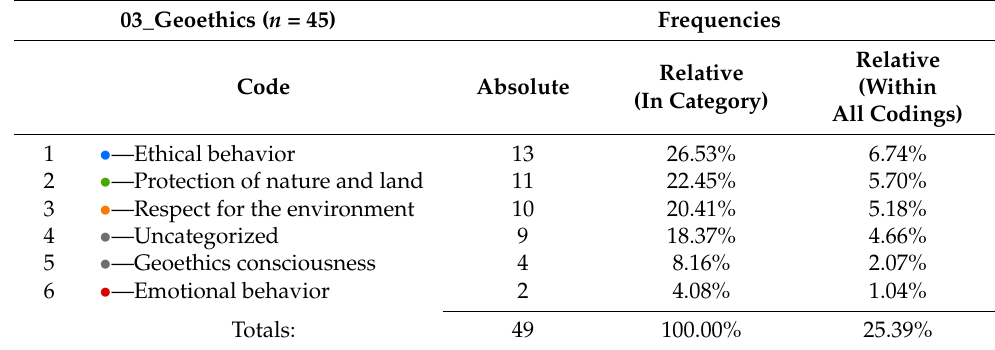
Table 4. Frequencies/distribution of codes (students’ perceptions) in category